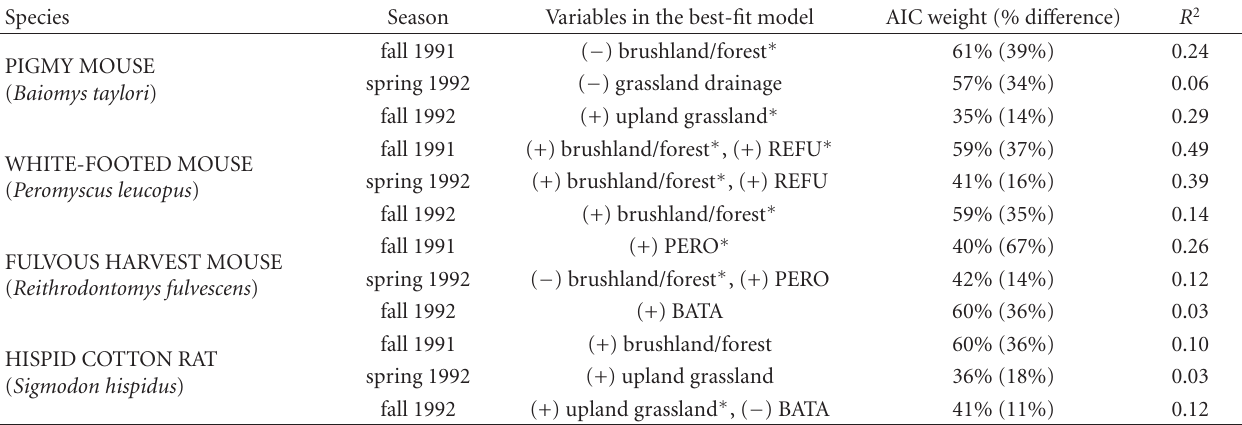
Table 1: Results of the best-fit spatial multiple linear regressions relating small mammal captures to three macrohabitat types and 3 other small mammal species (pigmy mice (BATA), white-footed mice (PERO), fulvous harvest mice (REFU), and hispid cotton rats (SIHI)). We report AIC weight and % di ff erence in AIC weights between the best-fit model (reported) and its most likely alternative model, and asterisks indicate significant explanatory variable in the best fitting